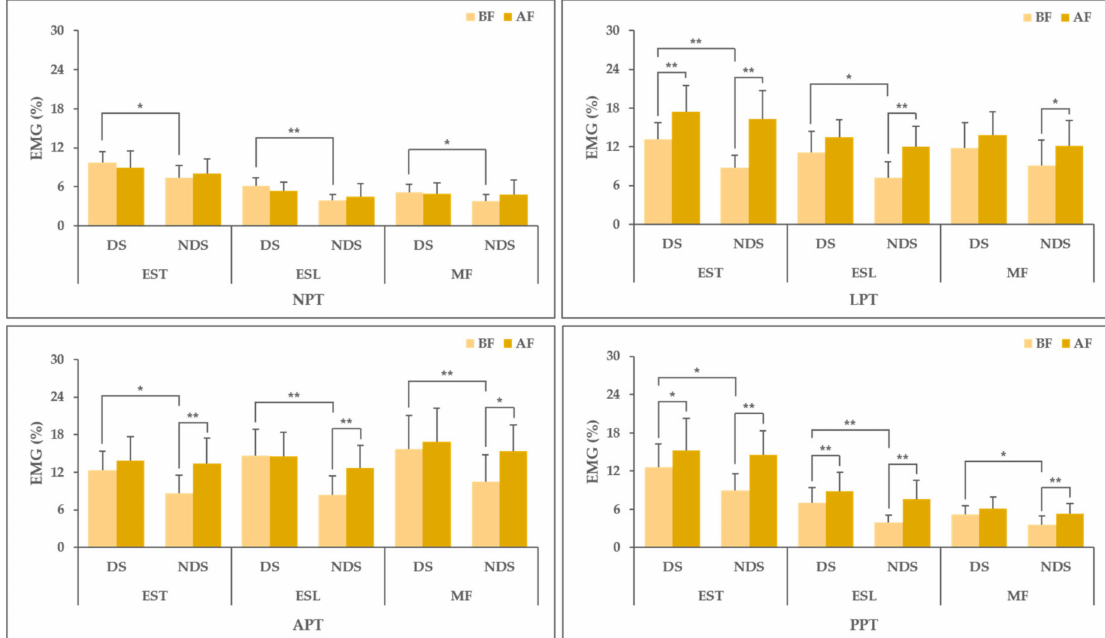
Figure 4. Differences in electromyographic (EMG) activities on the dominant side (DS) and non-dominant side (NDS) between before (BF) and after (AF) performing the exercise under four conditions: no pelvic tilt (NPT), lateral pelvic tilt (LPT), anterior pelvic tilt (APT), posterior pelvic tilt